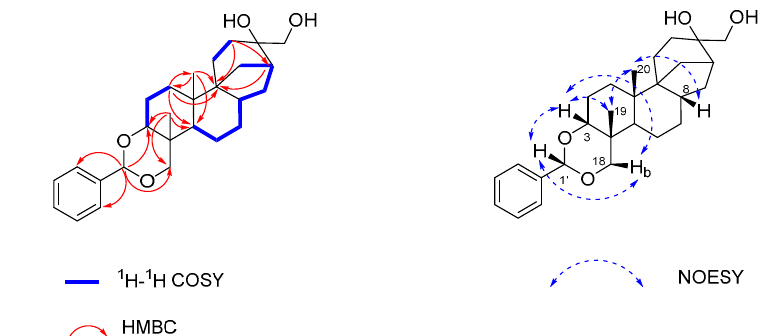
Figure 2. Key 1 H- 1 H COSY, HMBC and NOESY correlations for 1 .